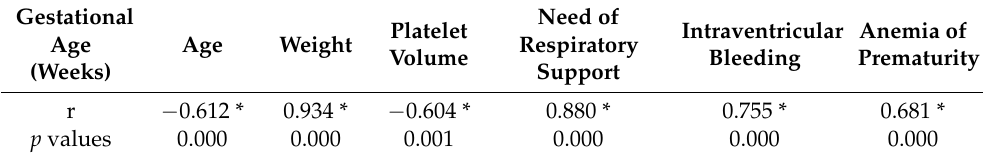
Table 6. Gestational age correlated with clinicopathological aspects and platelet volume in cases of preterm newborns.